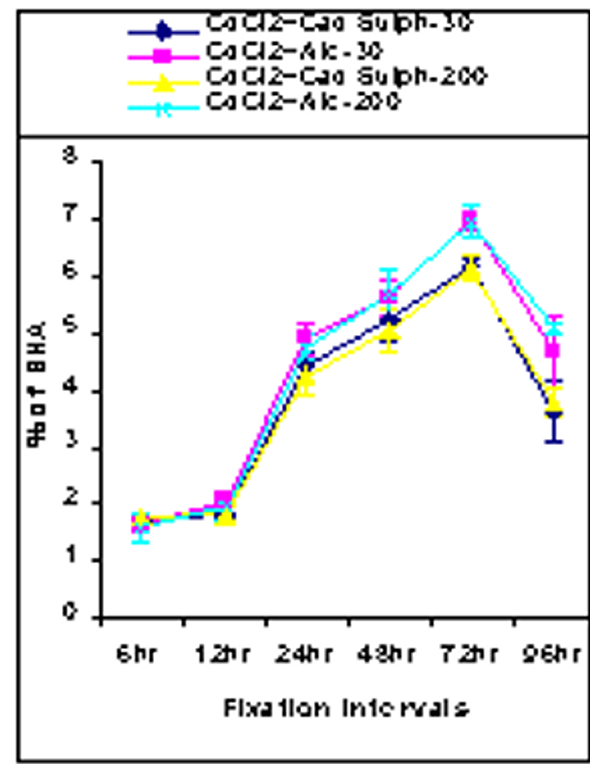
Figure 5 Showing time-dependent frequencies of Cad Sulph-30 pre- fed and Cad Sulph-200 pre-fed series versus their respective CdCl 2 treated alcohol-30 and alcohol-200 control